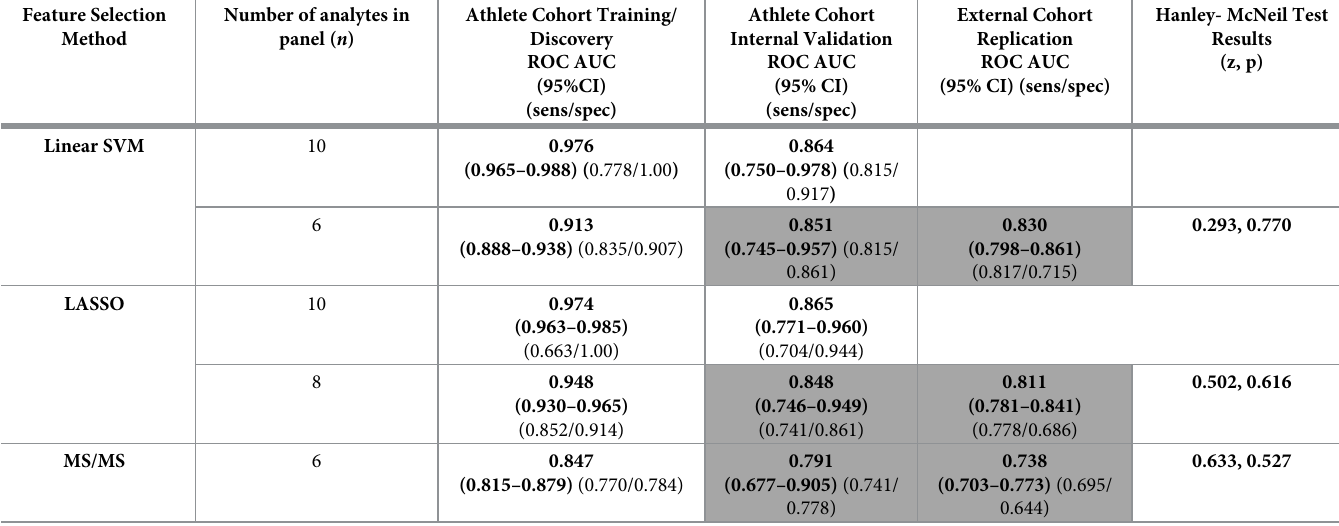
Table 4. Comparison of unmatched and matched biomarker panel results between Athlete and external cohorts. Feature Selection Method